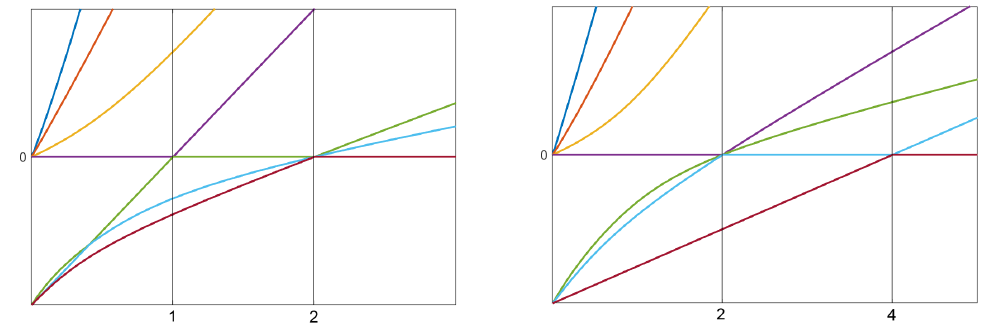
Figure 5: Two different 2 -crossings of two particular consistent weightings of G · G · G with G as in Figure